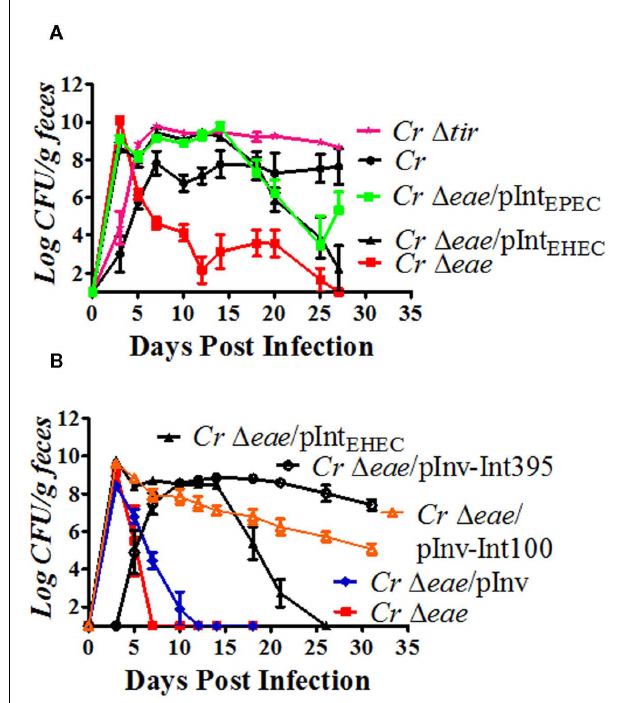
FIGURE 7 | Intimin but notTir is required for colonization of streptomycin pre-treated mice by C. rodentium . (A,B) Eight-week-old C57BL/6 mice were pre-treated with streptomycin in their drinking water for 48h prior to being inoculated with approximately 5 × 10 9 CFU of indicated C. rodentium strains by oral gavage (see Materials and Methods), with the exception of C. rodentium Δ tir in (A) , in which approximately 10 6 CFU were inoculated. Colonization was determined by viable stool counts, and shown are the averages CFU ( ± SEM) of three to five mice per group. [Note that the slightly lower level of colonization by C. rodentium Δ tir in (A) at three days post-infection was likely due to the lower inoculum used]. Each strain was tested in at least two independent